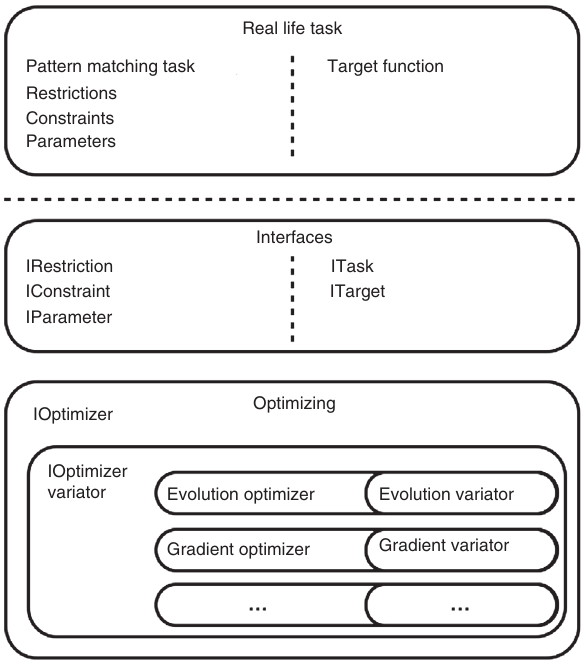
Figure 5. Full Three-Layer